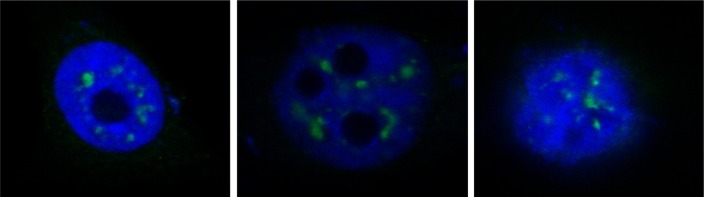
Additional images for the proximity ligation assay showed in Figure 4B.Hela cells were transiently transfected with FLAG-tagged IRAK2. Mouse anti-ALYREF and Rabbit anti-FLAG antibody were used for the proximity ligation assay. Green dots present the interaction of IRAK2 with ALYREF.